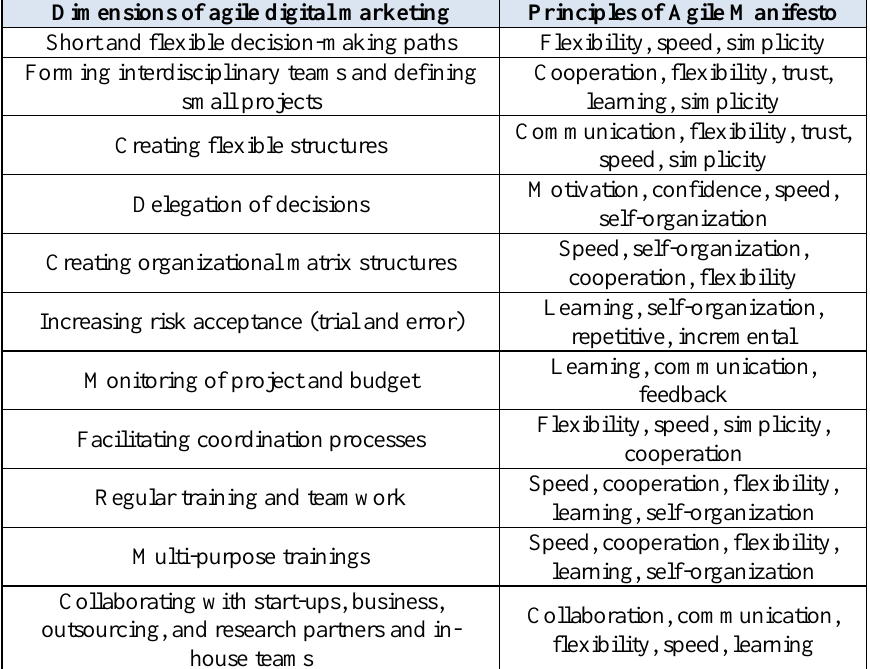
Table 6. Applied Categorization of Digital Marketing Dimensions. Traditional Category